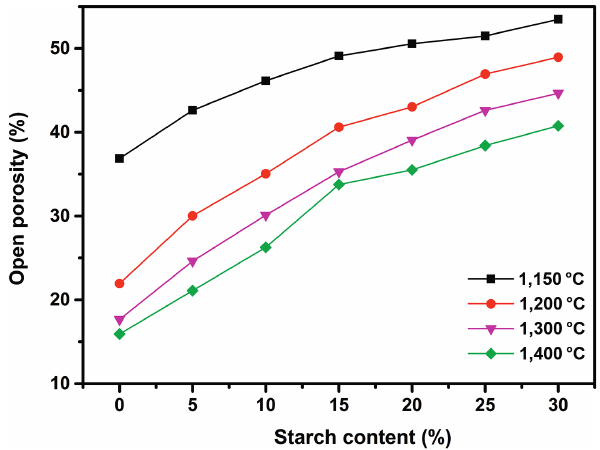
Figure 5: Comparison between porosity plots of samples with dif- ferent starch